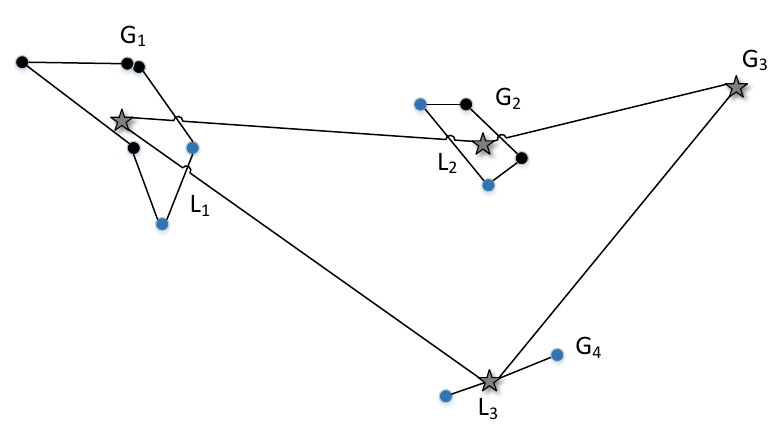
Figure 6. The processes to initialize the population with k-means clustering.